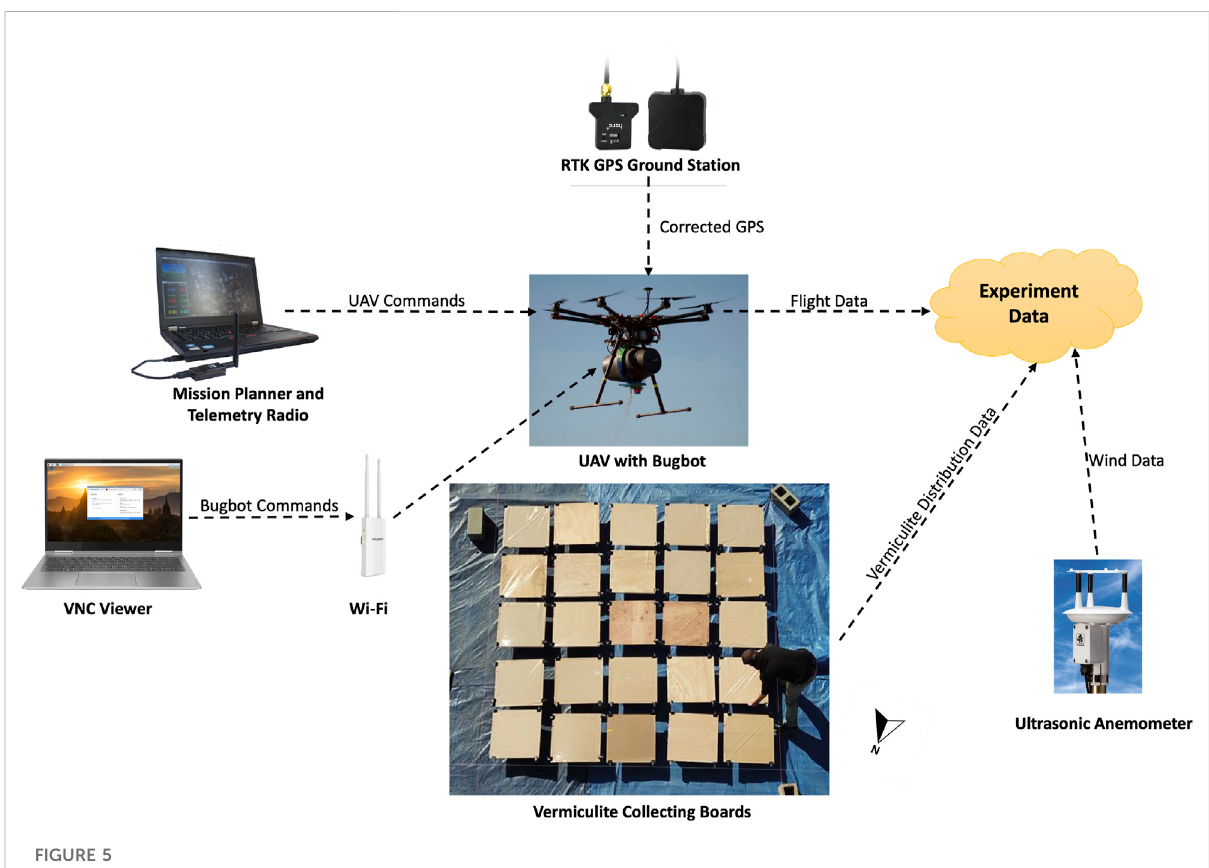
FIGURE 5 A block diagram illustrating our data collection